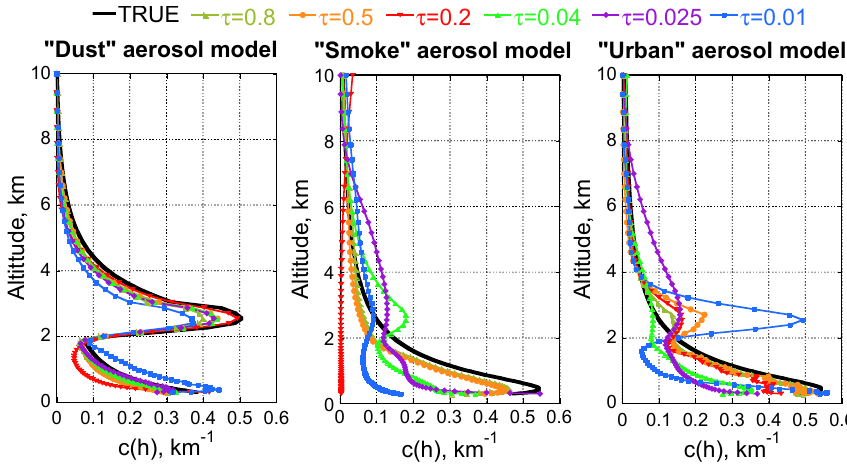
Fig. 9. Retrievals of the vertical distributions of aerosol components under different